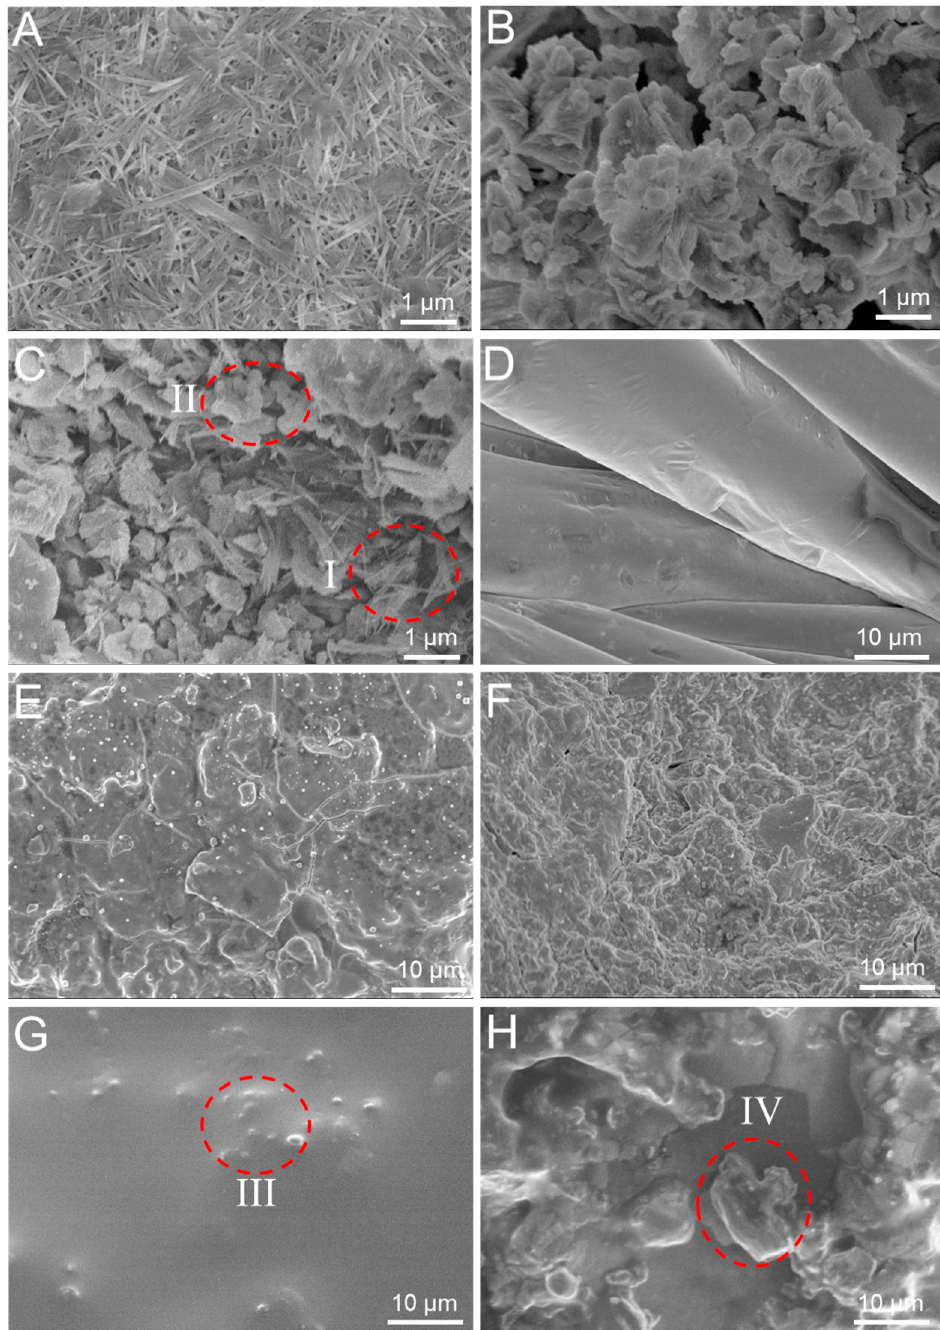
Figure 5. SEM images of ( A ) ATP, ( B ) CaO, ( C ) OATP/CaO, ( D ) TWL, ( E ) surface and ( F ) interior of OACT, ( G ) surface and ( H ) interior of OACT@ASO. Regions I and II note ATP and CaO. Regions III and IV note ASO.